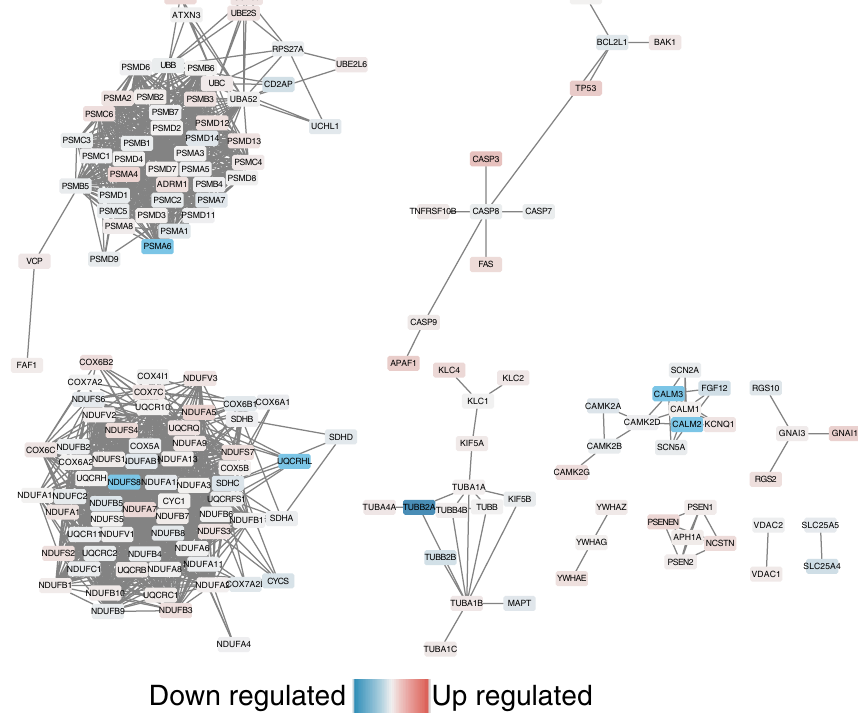
Figure 2. The constructed PPI network with PD-related genes. The red nodes represent up-regulated genes and the blue represent down-regulated genes in GSE99039. Visualization tool: Cytoscape (3.7.2). https:// cytos cape.